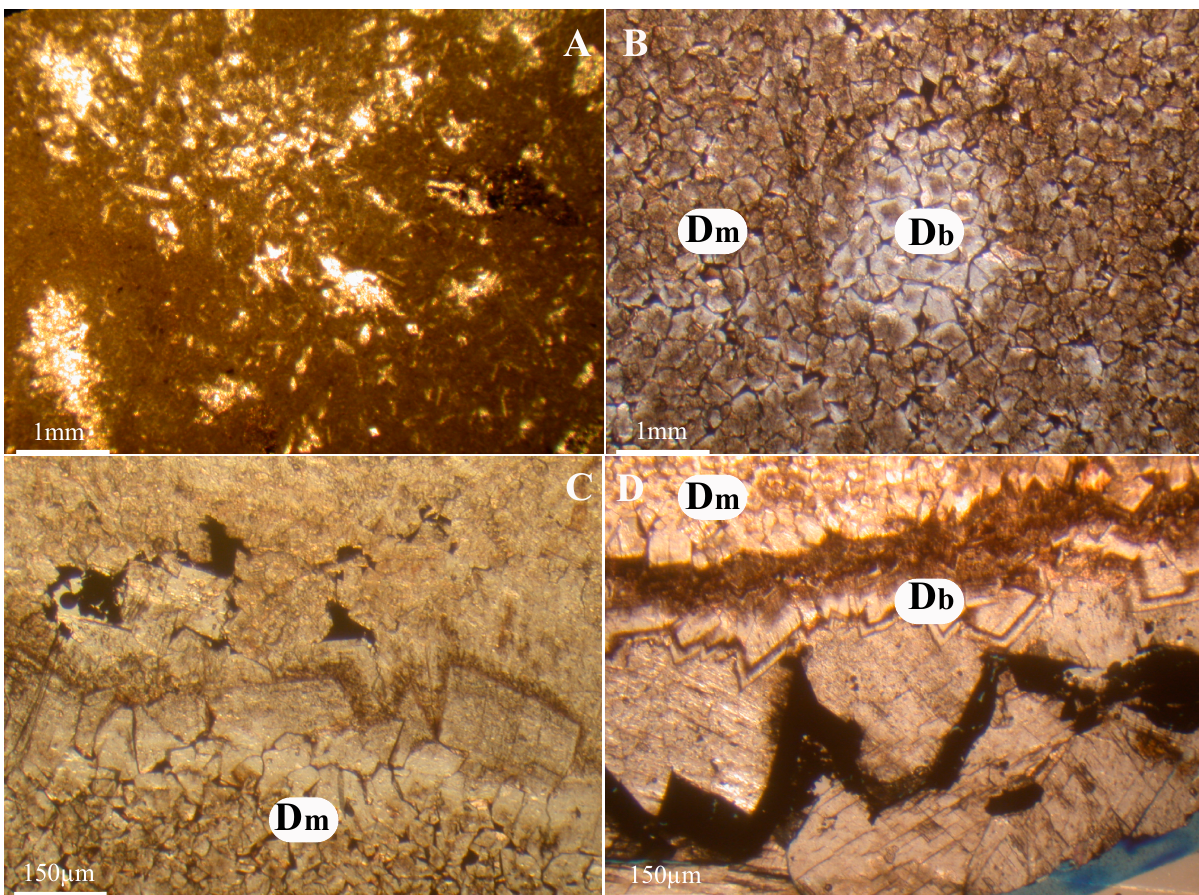
Figure 5. Photomicrographs illustrate: ( A ) The needle shape of evaporites within the mudstone microfacies that filled the pore spaces, ( B ) early dolomitizing cement (D m ) were mostly preserved the previous pristine facies “dark brown colour”, while in the central part of the photo the rhombohedral shape of dolomite which precipitated later. The lower part ( C ) and upper part ( D ) of the photos show the predating cement formation “D m ” and the coarse grains of dolomite “D b ” from the late dolomitizing fluids.